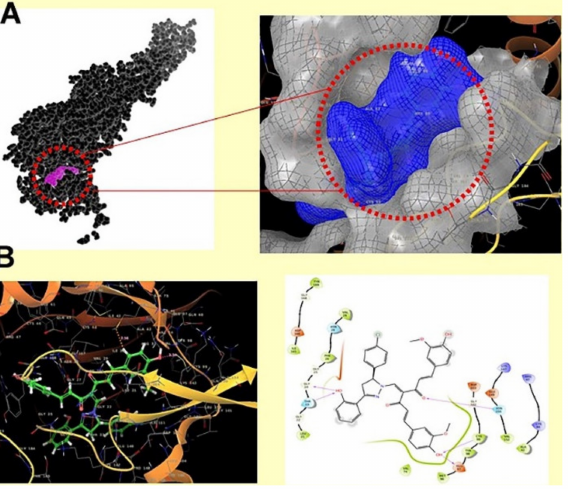
Figure 37. Compound 33 (cid:48) s molecular docking complex with IKK β . ( A ) Interaction complex of IKK β with compound 33 (docking score = − 11.874). Next to it the zoomed-in view of the interaction of compound 33 into binding grooves displayed in surface binding view. ( B ) 3D view of compound 33 (ball-stick view) binding mode with key amino acids (cartoon view). The 2D pose view is also shown next to it